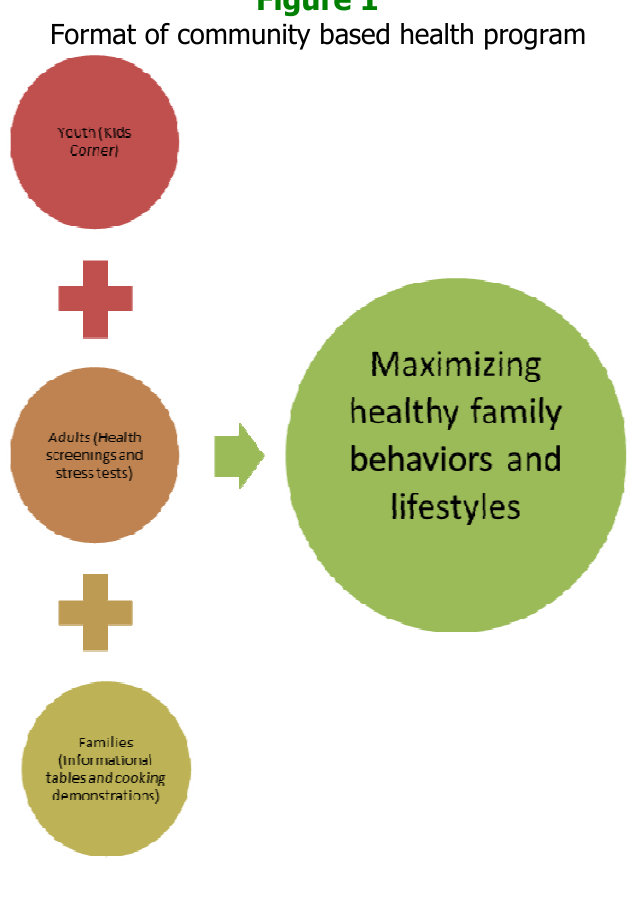
Format of community based health